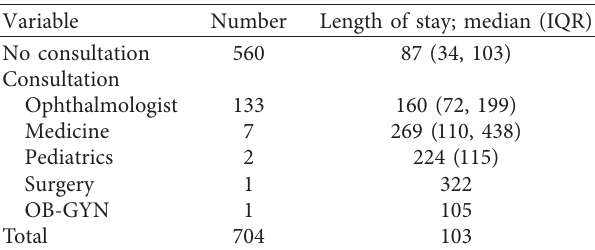
Table 9: Emergency department length of stay classified by